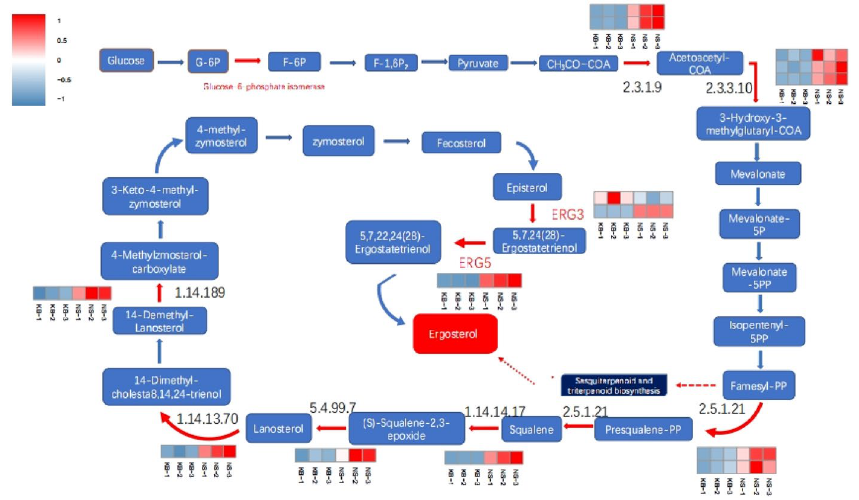
Figure 3. The pathway of ergosterol synthesized by C. cicadae